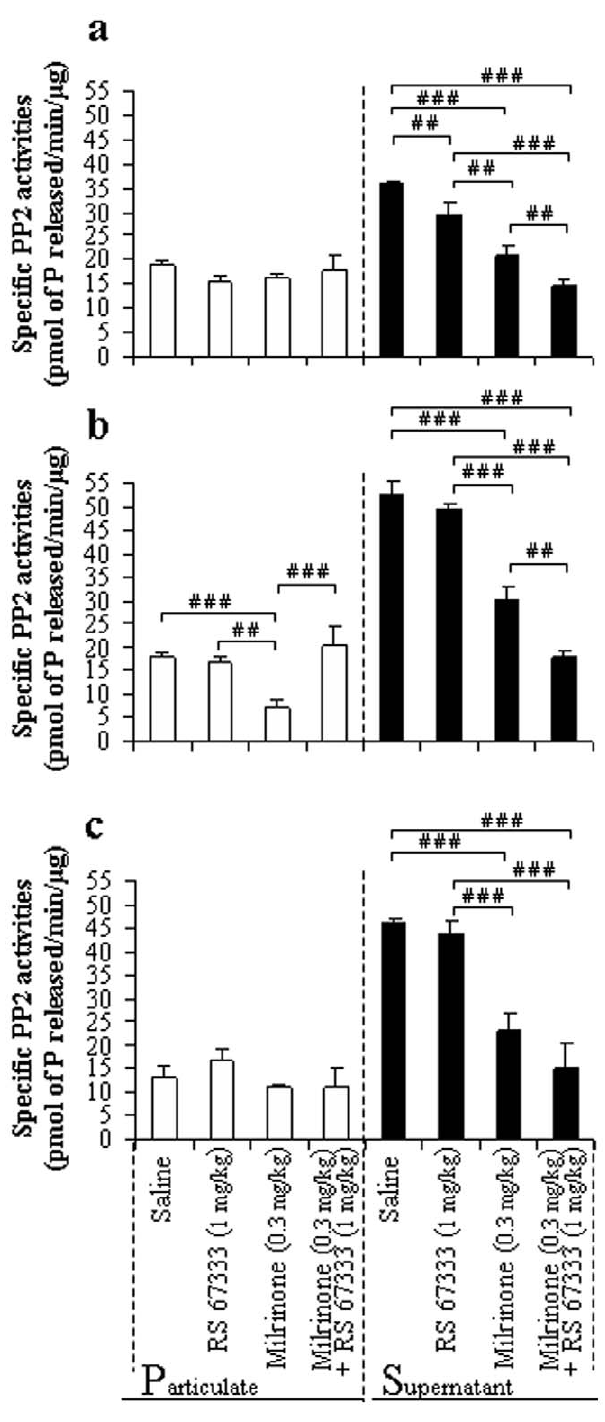
Figure 7. Effect of milrinone (0.3 mg/kg) on PP2 activities in hippocampus, prefrontal and perirhinal cortices from rats performing the object recognition task with a 4-h delay. Rats were injected with the inhibitor of PDE3 (milrinone, 0.3 mg/kg) 45 minutes before exposure then with saline or the 5-HT4 receptor agonist (RS 67333, 1 mg/kg), 30 minutes before exposure to the sample trial of the object recognition task. Immediately after the testing trial, both particulate (white bar) and soluble (black bar) fractions from the hippocampus ( a ), the prefrontal cortex ( b ) and perirhinal cortex ( c ) were isolated and were assayed for PP2 activity. PP2 activities were pmol of phosphate released by min and mg protein. Results are